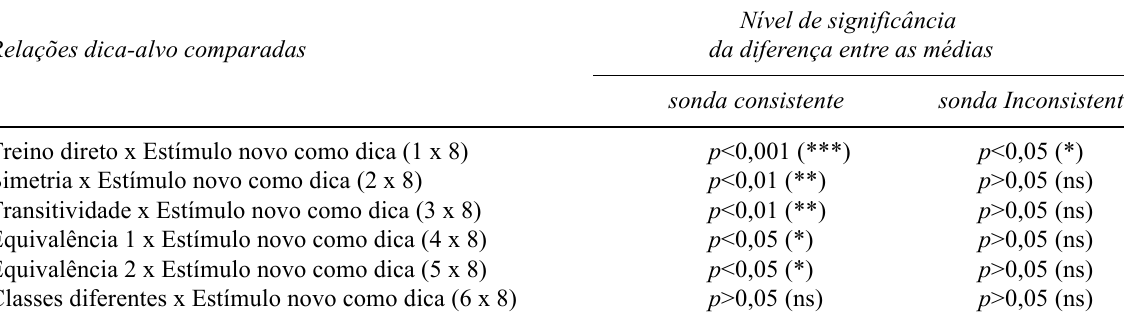
Figura 4 apresenta as avaliações do Grupo Um-para- Muitos e a parte inferior apresenta as avaliações do Gru- po Muitos-para-Um. Essas avaliações das figuras equi- valentes foram feitas pelos participantes dos dois grupos experimentais que tiveram desempenhos consistentes nos blocos de sonda.